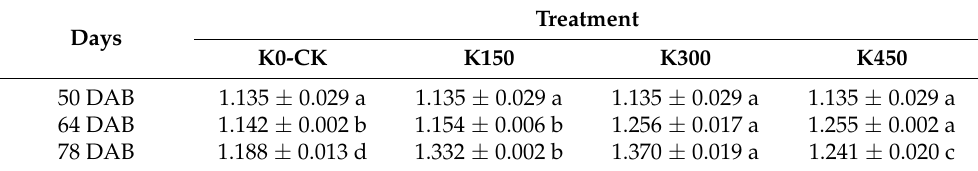
Table 2. Potassium content of grape fruit (mg · g − 1 ).